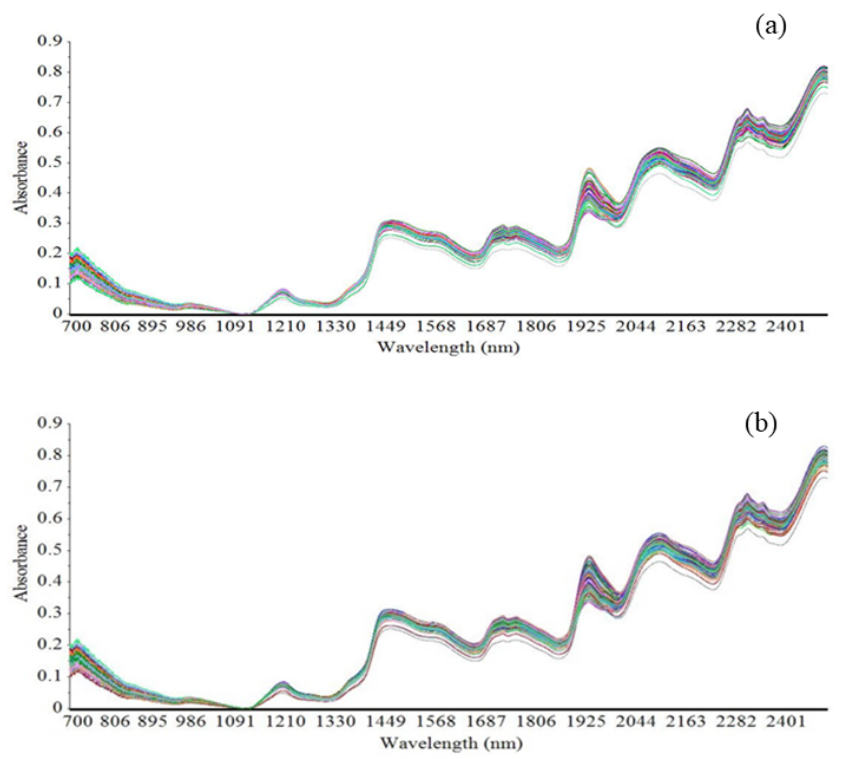
Figure 1. Typical near-infrared spectra of ( a ) hulled oat samples and ( b ) naked oat samples. Thus, iPLS was performed for the selection of important wavelengths for the prediction of β -glucan in oats. Furthermore, the correlation matrix plots were employed to determine the correlation between each wavelength range and the β -glucan content. The correlation between wavelength range 700–1300 nm and 1400 to 1700 nm with the β -glucan content of hulled oat samples are shown in Figure 2a or Figure 2b, respectively. It can be observed that the wavelengths ranging from 1091 to 1218 nm present low correlation values (less than 0.2) compared with the other wavelengths (equal to greater than 0.2). The wavelengths from 1400 to 1700 nm also exhibit negligible correlation with β -glucan measurements. Thus, these wavelengths with less correlation were least important and considered as outliers for the determination of β -glucan to reduce the error, whereas the wavelength range 1300–1400 nm presented a strong negative correlation and the wave- length range 1700–1900 nm exhibits a strong positive correlation with β -glucan content. Thus, these wavelength ranges in group II with strong correlation were important for the prediction of β -glucan. Similarly, the important wavelengths (1950–2050 and 2150–2500 nm) were identified from group III (1900–2500 nm) using the correlation matrix, as shown in Figure 2c. The correlation matrix plots between β -glucan and the different wavelength ranges for the naked samples are presented in Figure 2d–f. As shown in Figure 2e or Fig- ure 2f, wavelength ranges 1850–1865 nm and 1900–2000 nm exhibit a negative correlation with β -glucan, respectively. The wavelengths with correlation values of more than 0.1 were used for the development of a model, and the other wavelengths with low correla- tion values were considered outliers for the development of regression model.